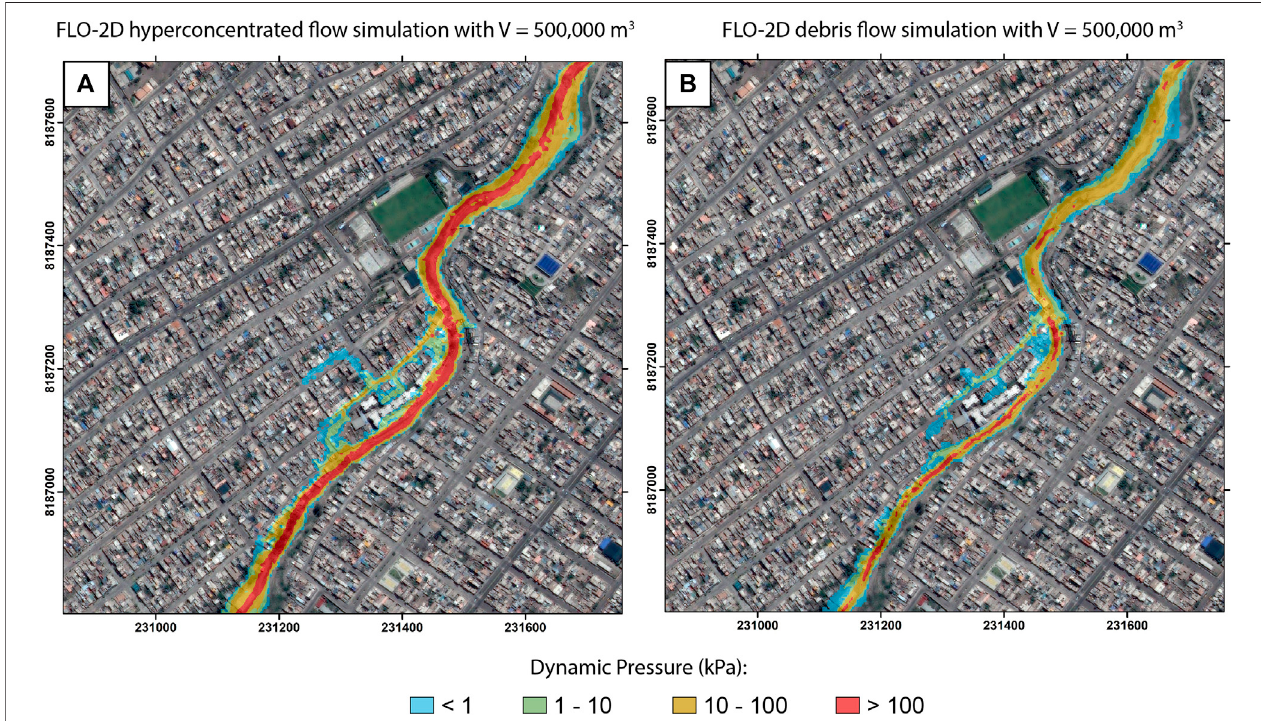
FIGURE7| Mapsofsimulateddynamicpressure(inkPa)obtainedfromFLO-2Dsimulationsinachannelsection(J.OlayabridgelinkingtheMira fl oresandAltoSan Alegre districts) of the San Lazaro catchment for (A) HCF and (B) DF, both with a volume of 5 × 10 5 m 3 .